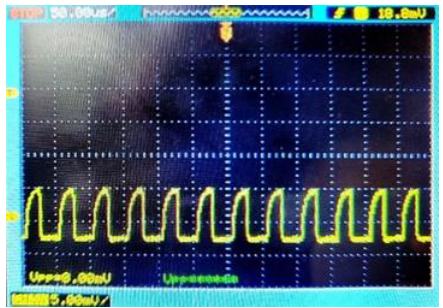
Figure 13. Optically measured pulse response of the proposed optoelectronic Rx IC.